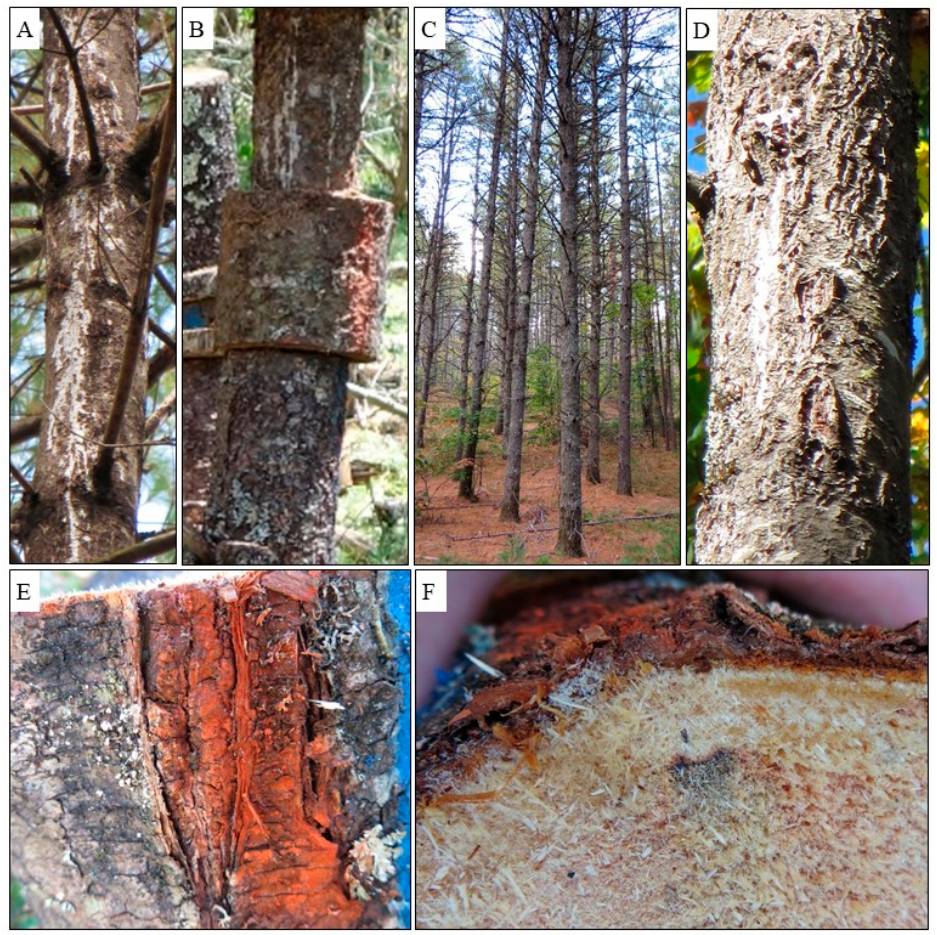
Figure 1. Common symptoms of Caliciopsis canker damage. Symptoms include ( A–B ) heavy resin production, particularly between whorls, ( C ) thinning crowns with as little as 5% live crown, ( D ) roughened bark in the mid- to upper-crown, ( E) bark fissures/cracks, which are associated with ( F ) necrotic tissue and internal cankers. The ( F ) internal canker with necrotic tissue is associated with the ( E ) large bark crack that has sealed over.